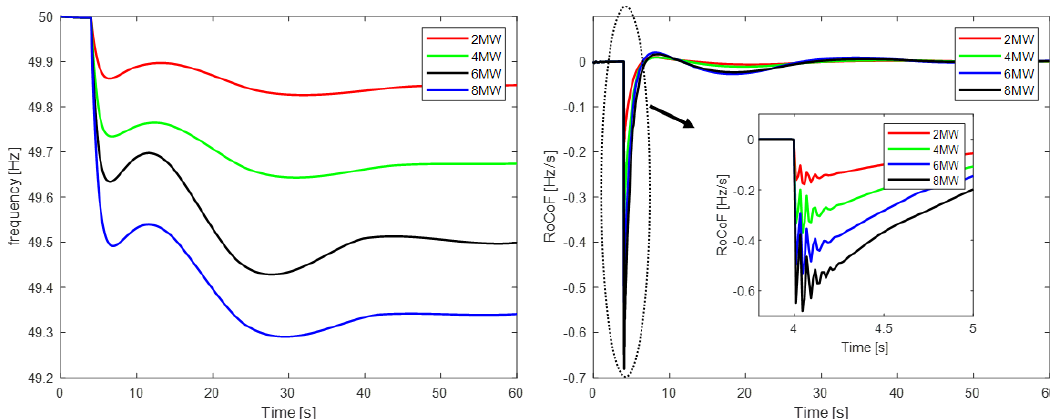
Figure 12. Load step-change frequency response and RoCoF for the future worst case with the BESS installation.